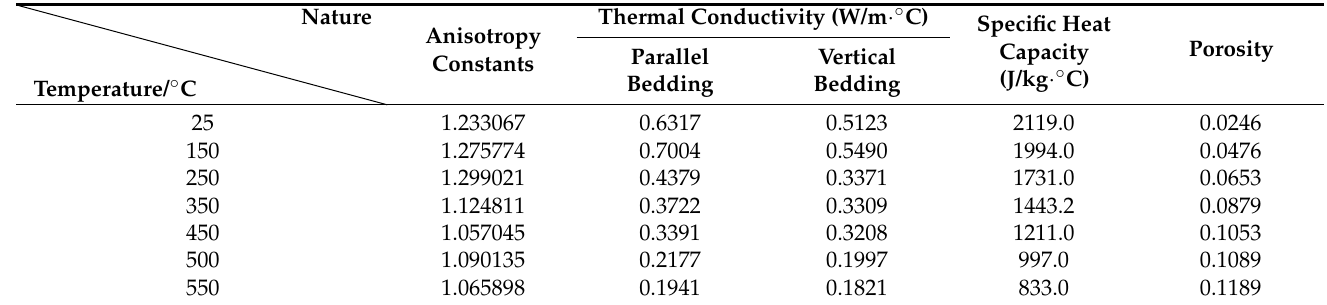
Table 4. Thermophysical properties of Fuyu oil shale.